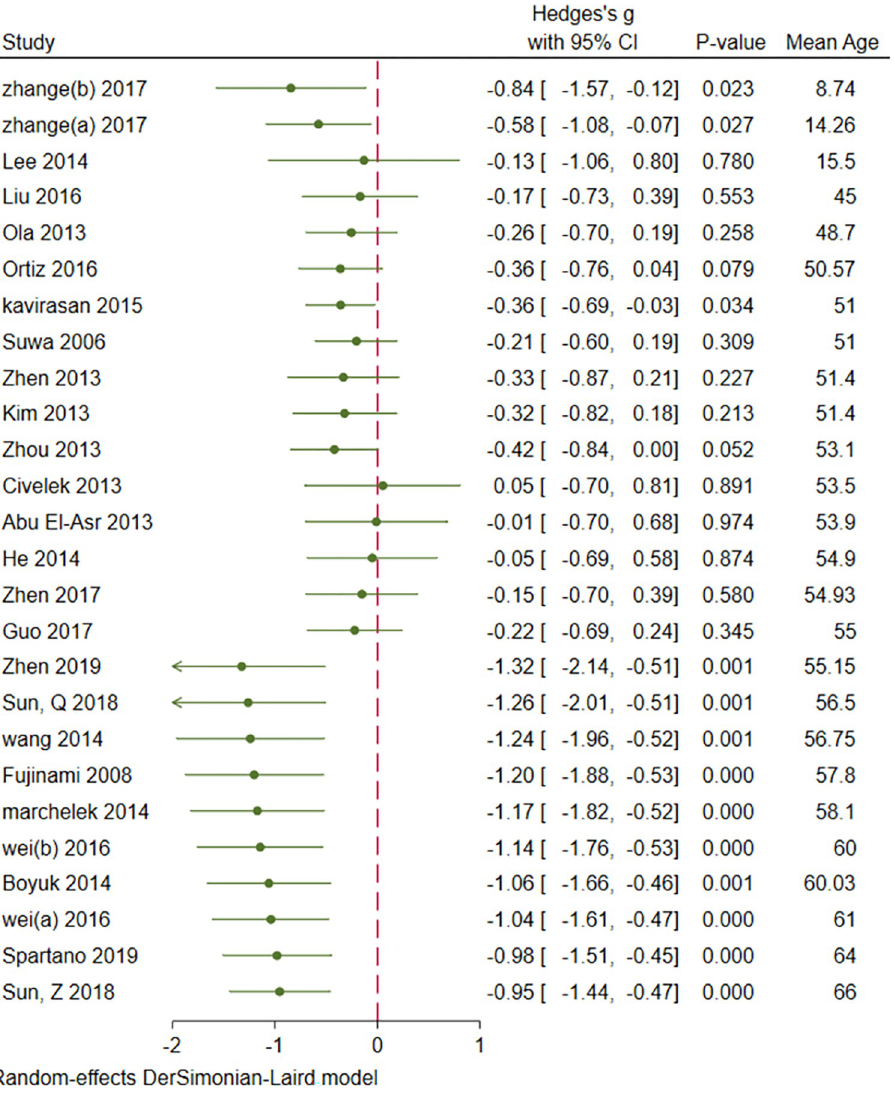
Fig 8. Cumulative meta-analysis of BDNF levels in patients with DM by the mean age of cases.